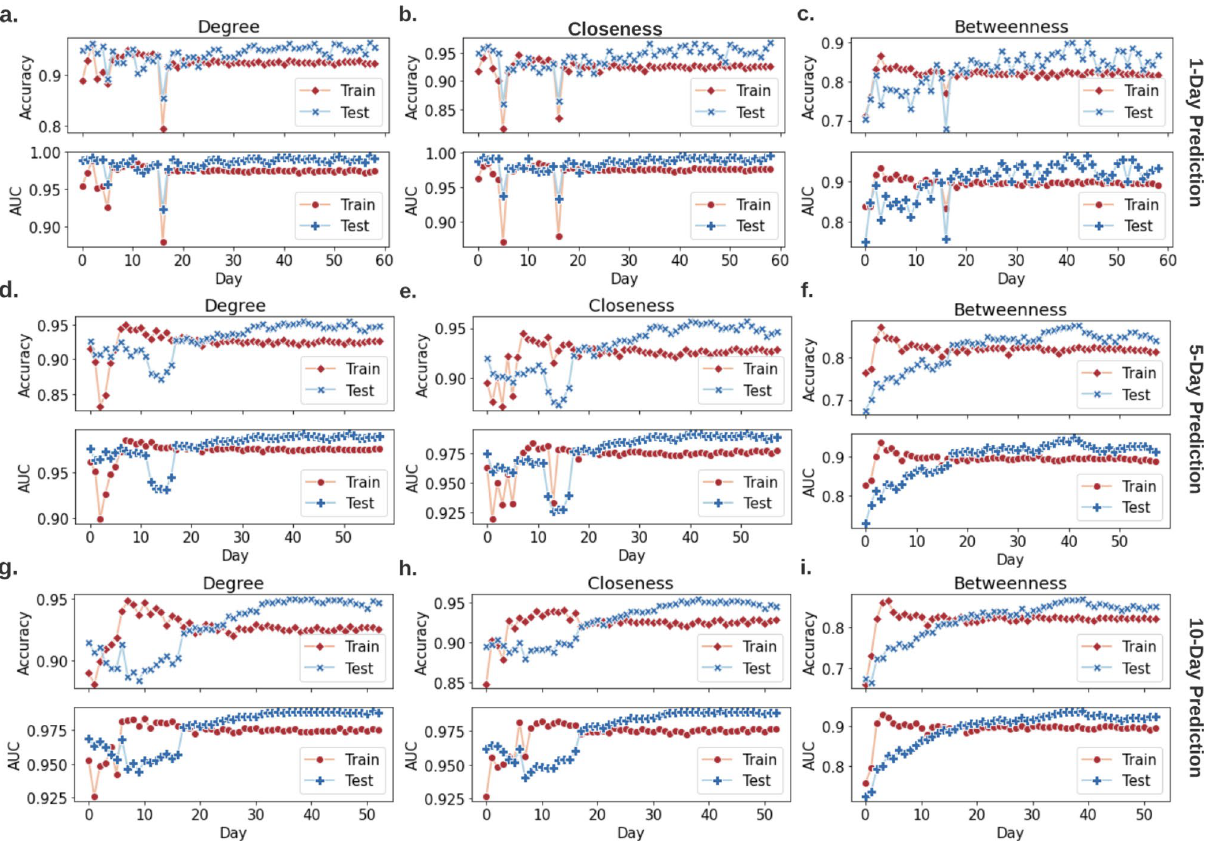
Figure 6. Centrality predictions of daily misinformation networks. To predict day(s) t ’s central nodes with respect to degree, closeness, or betweenness centrality, daily misinformation networks prior to day(s) t are used as training data. Instead of network topology, e.g., adjacency matrix, we take the natural language embedding of each misinformation as the input to the DNN. The DNN then predicts which nodes are going to be the top 100 central nodes in day(s) t . E.g., in 1-day prediction, we predict day 10’s top nodes based on day 0–9’s information; and in 5-day prediction, we predict days 5–10’s top nodes based on day 0–5’s